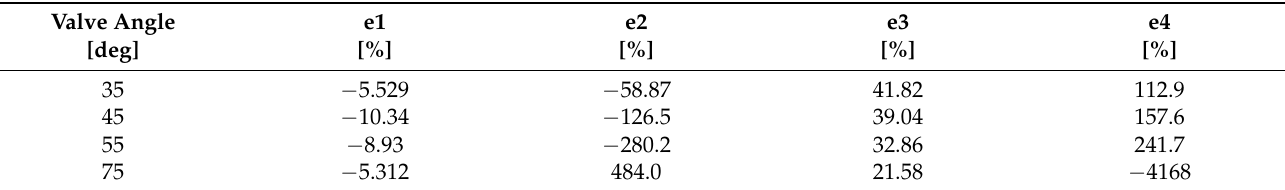
Table 8. Simulation Cases: error metrics.